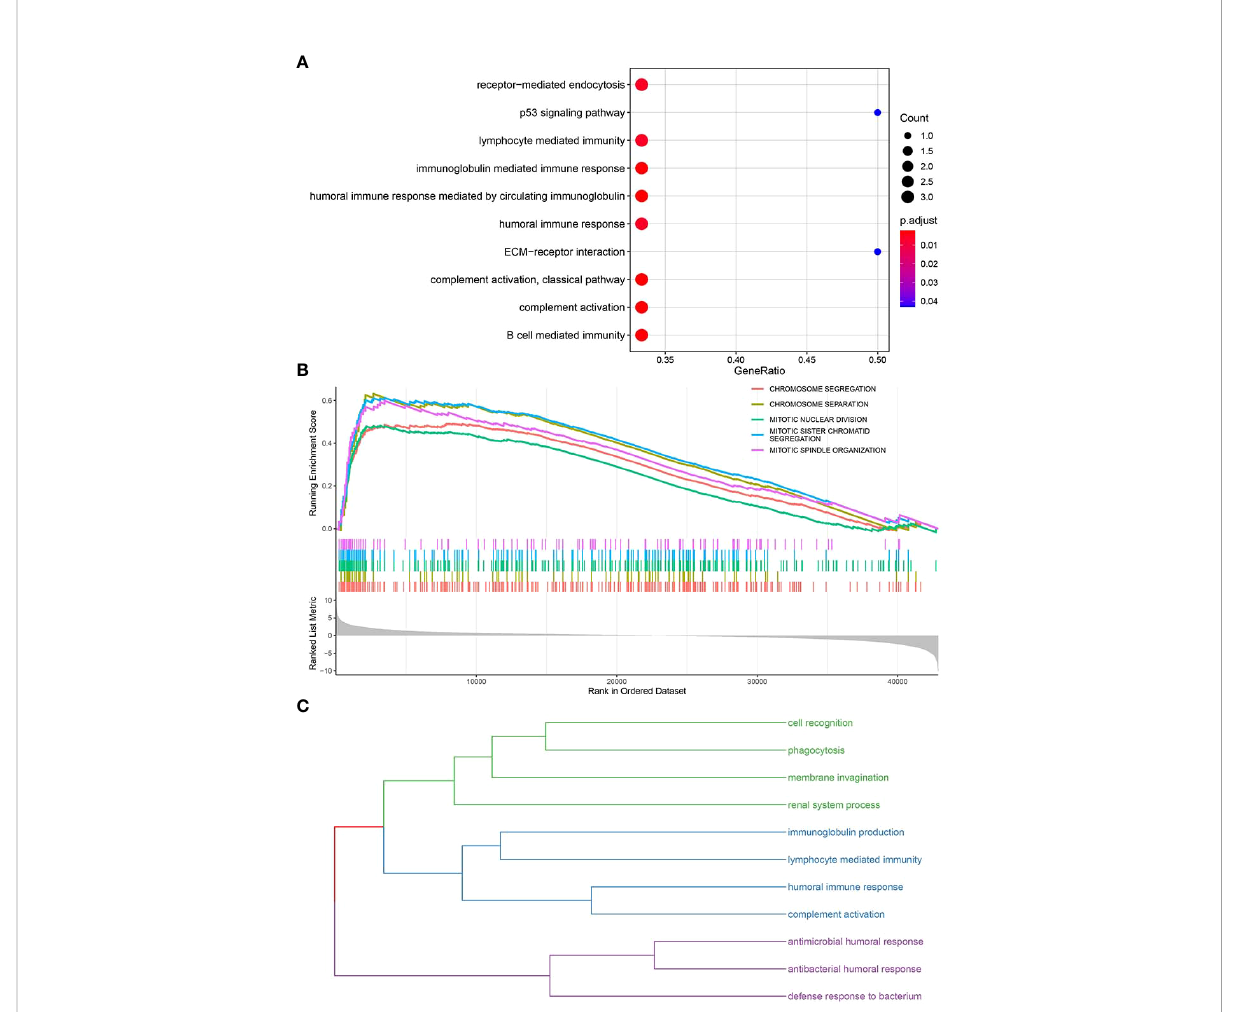
FIGURE 6 Enrichment analyses of key functional genes and pathways. (A) Bubble plot for enriched GO-BP and KEGG pathways related to key pyroptosis factors. (B) GSEA for enriched pathways in the TCGA-BRCA samples. (C) The enriched pathways in panels (A, B) are classi fi ed into three major categories of biological functions based on